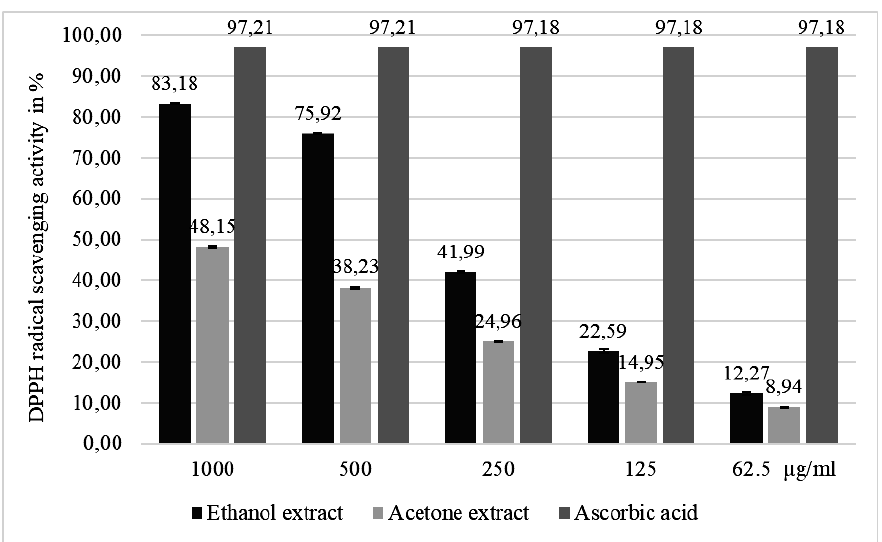
Figure 4. DPPH radicals scavenging activity of ethanol and acetone extracts of T. officinale.